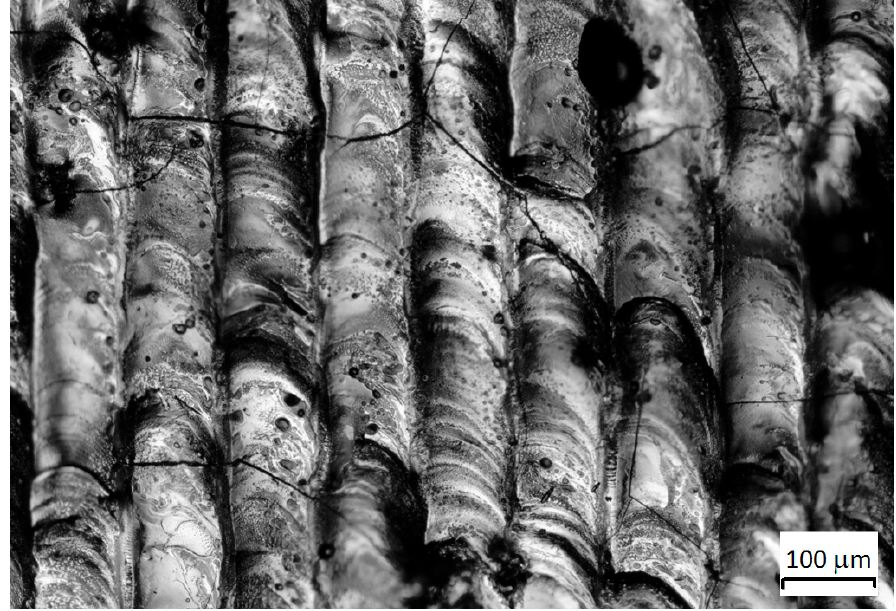
Figure 8. Cracks on the surface of the monolayer—94 wt% WC and 6 wt% Co P = 120 W, V = 300 mm/s. Rational regimes were established for a mixture of 94 wt% WC and 6 wt% Co: scanning speed—300 mm / s, powder layer thickness—20 µ m, laser power—50–70